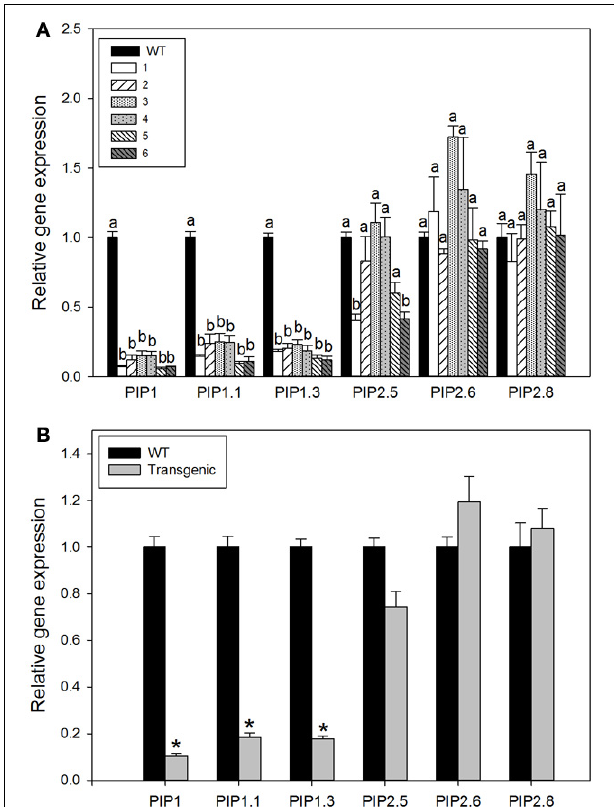
FIGURE 2 | Relative expression of aquaporin genes in the leaves of wild-type and transgenic lines. Each histogram is the average of three independent biological samples with two technical replicates; the error bars represent SE. (A) Relative expression of single gene for each plant group is shown. Letters denote homogeneous groups based on the Fisher LSD corrected for the multiple comparisons. ANOVA analysis revealed presence of significant differences between wild-type and transgenic lines for all PIP1 genes tested and for PIP2.5 gene ( p < 0 . 05). (B) Relative gene expression for pooled data from all transgenic lines tested against expression level in wild-type plants. Stars denote significant difference ( P < 0 . 001, Student’s t